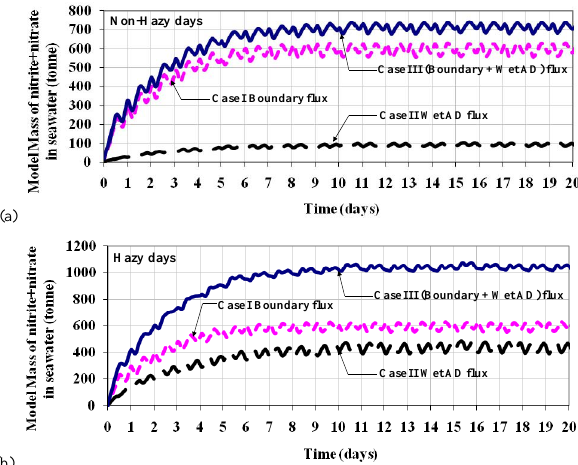
Fig. 6. Increase of nitrite+nitrate mass in the Singapore Strait due to atmospheric fluxes during (a) non-hazy days and (b) hazy days. Note: Mass due to the total flux (Case III) = Mass due to boundary fluxes from the ocean (Case I) + Mass due to atmospheric nitrite+nitrate deposition (AD) fluxes (Case II).